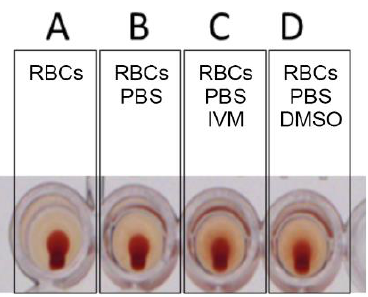
Figure 3. Controls: ( A ) RBCs alone, ( B ) RBCs with PBS, ( C ) RBCs with PBS and IVM and ( D ) RBCs with PBS and DMSO. No HA is observed. with PBS and DMSO. No HA is